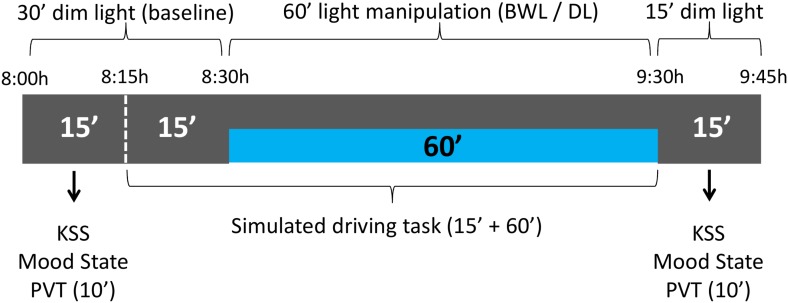
schema of the experimental protocol. The participants remained the first 30 min of the session under dim light, while they carried out the baseline subjective scales and PVT, followed by 5 min of driving practice and 10 min of baseline driving. After that, one of the lighting conditions (blue-enriched white – BWL – or dim light – DL –) was applied while they drove for 60 min. Finally, they performed the PVT and subjective scales for a second time in dim light.